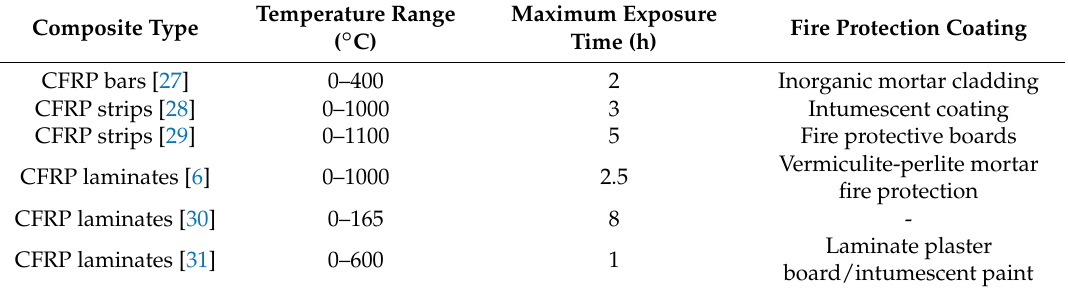
Table 1. Exposure conditions of carbon fiber-reinforced polymers (CFRPs) at elevated temperatures for engineering